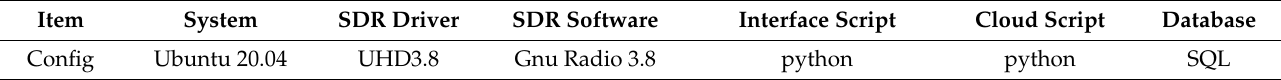
Table 5. Basic configure of Raspberry Pi 4.